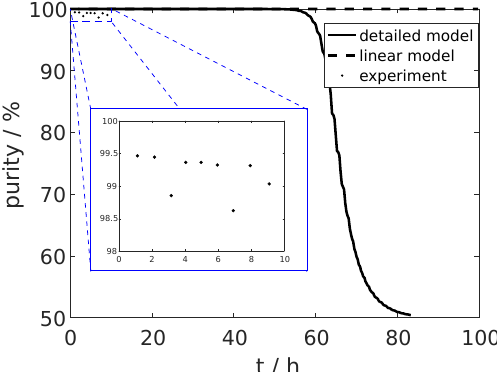
Figure 10. Comparison of the crystal phase purity in the linear model with the product purity in the detailed model from [7] and with the experimental product purity from [8]. The inset figure gives a close-up view of the experimental